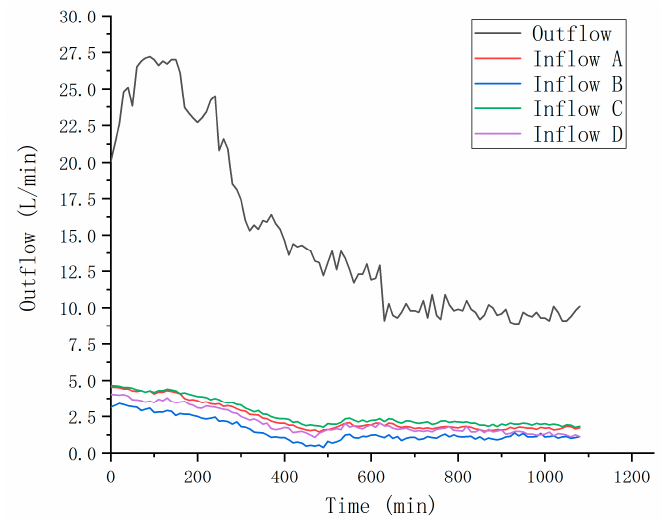
Figure 7. Inflow and outflow over time.